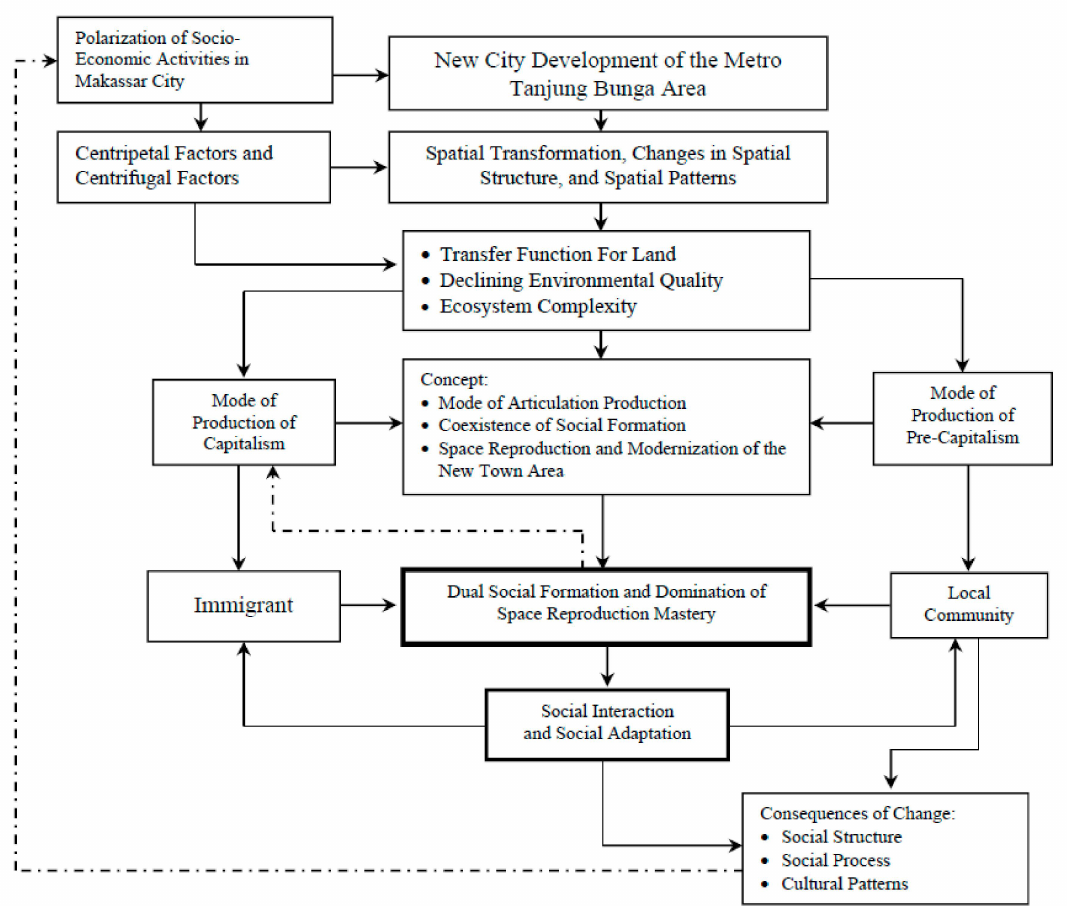
Figure 1. Conceptual framework of the new city area Metro Tanjung Bunga, Makassar